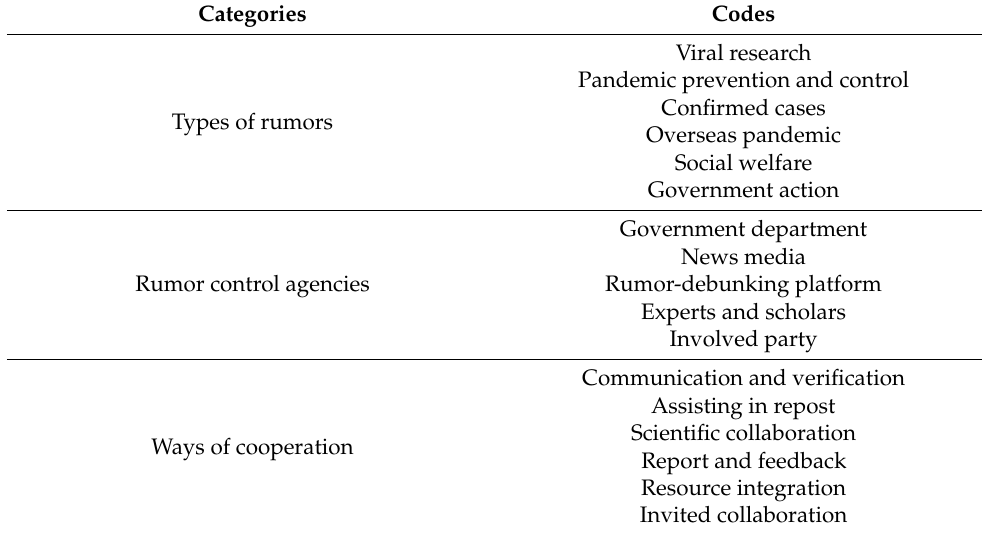
Table 2. Three code